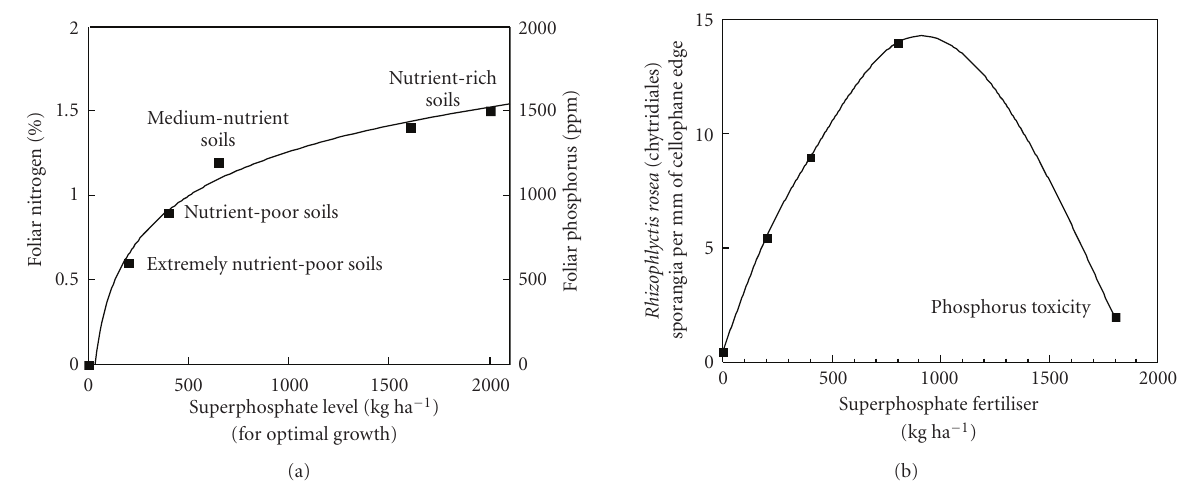
Figure 3: (a) Both foliar phosphorus and foliar nitrogen levels in overstorey leaves increase to an asymptote in the soil nutrient gradient from extremely nutrient-poor to nutrient-poor to medium-nutrient to nutrient-rich habitats (after [16]). Foliar N = 0 . 877 LOG (Super-PO 4 optimum) − 1.374 ( n = 6, r 2 = 0 . 97). Relative to plant formations on medium-nutrient soils, annual shoot growth (dry weight measured in t ha − 1 ) in major plant formations on nutrient-poor soils is about 60% less, 50% less on extremely nutrient-poor soils, and 130% more on nutrient-rich soils [16, 36]. (b) Response of the chytrid fungal species, Rhizophlyctis rosea , to the addition of superphosphate (kg ha − 1 ) to fertilized plots of heathland vegetation at Frankston, Victoria (after